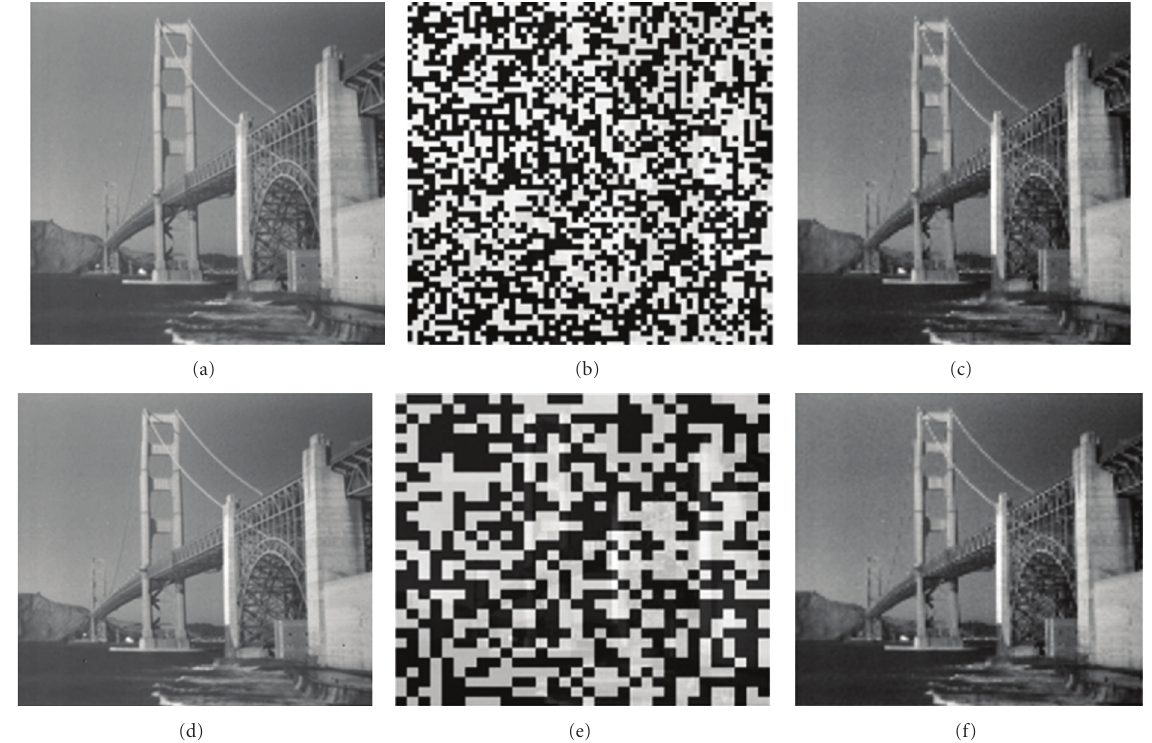
Figure 4: Results of application of chaotic algorithm to SF.GIF. (a) and (d) original image. (b) and (e) Image resulting from encryption with L1 or L2, respectively, using only one external encryption key in the larger size. (c) and (f) Reconstructed image in each case.